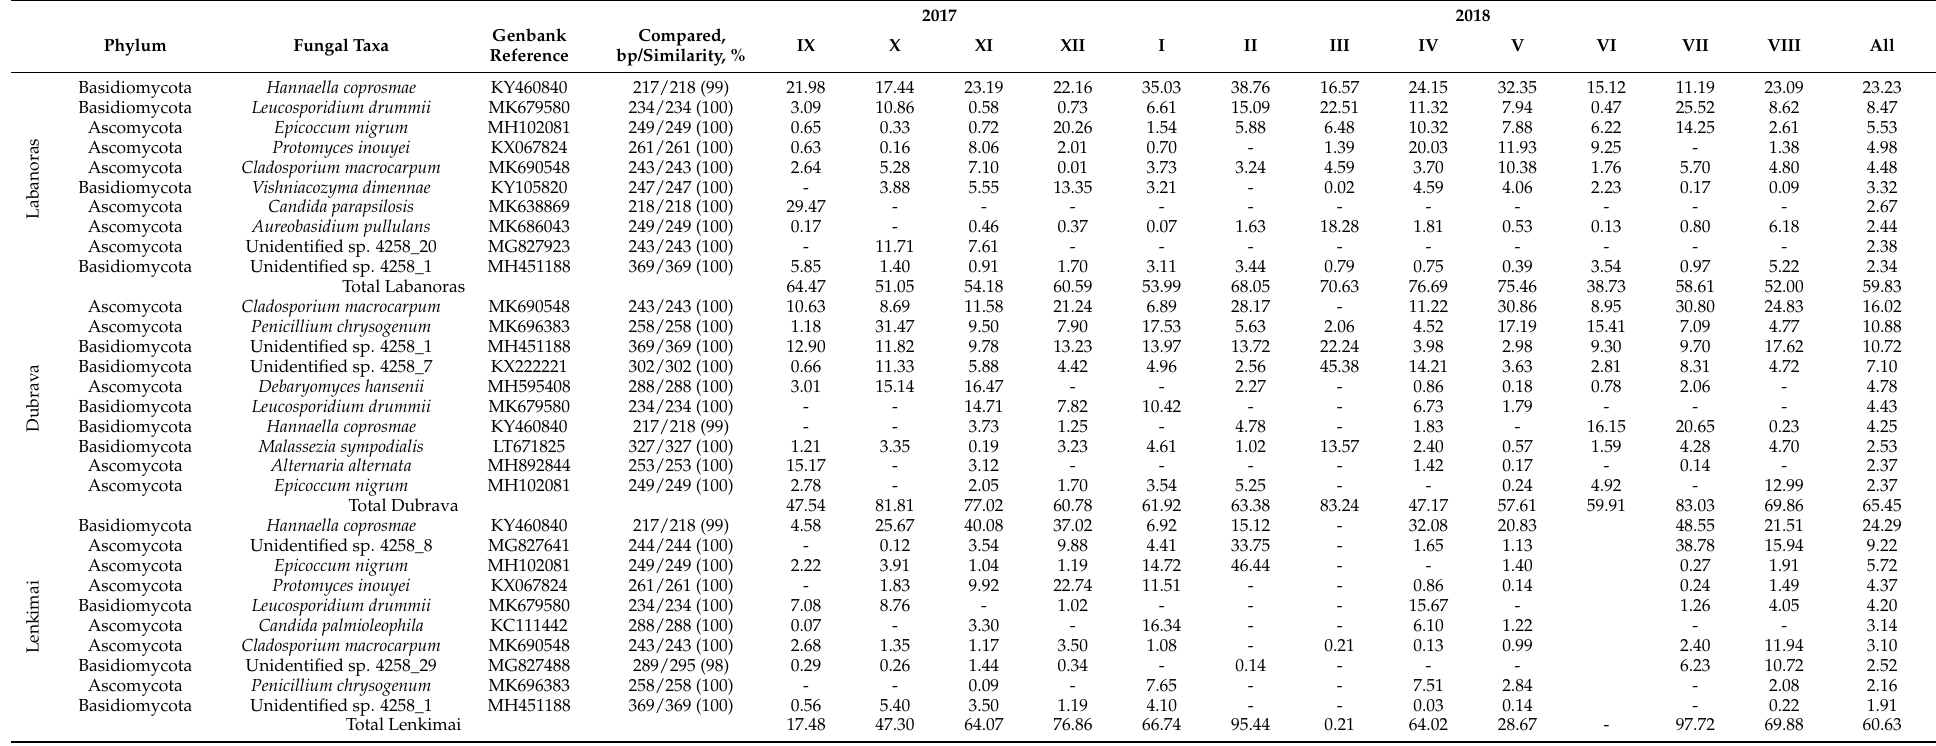
Table 2. Occurrence and relative abundance of the 10 most common fungal taxa (shown as a proportion of all high-quality fungal sequences) from spore trap samples collected between September 2017 and August 2018 in Labanoras, Dubrava, and Lenkimai